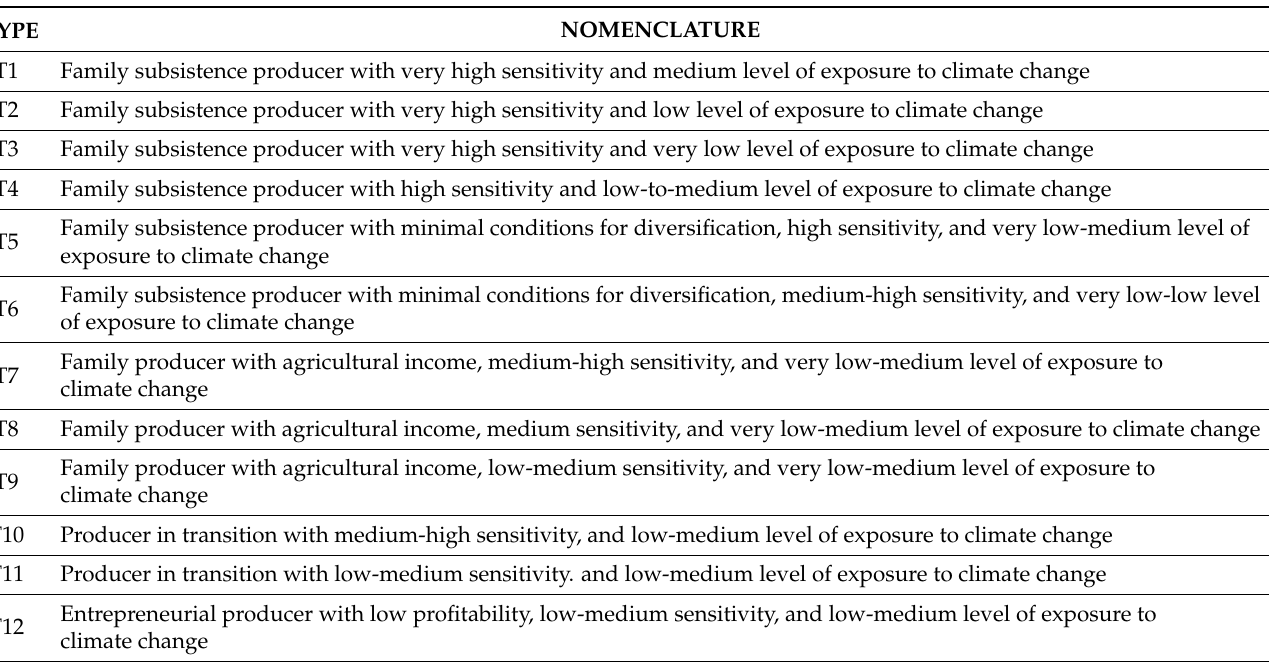
Table 7. Nomenclature of each producer type obtained with the Dalenius & Hodges